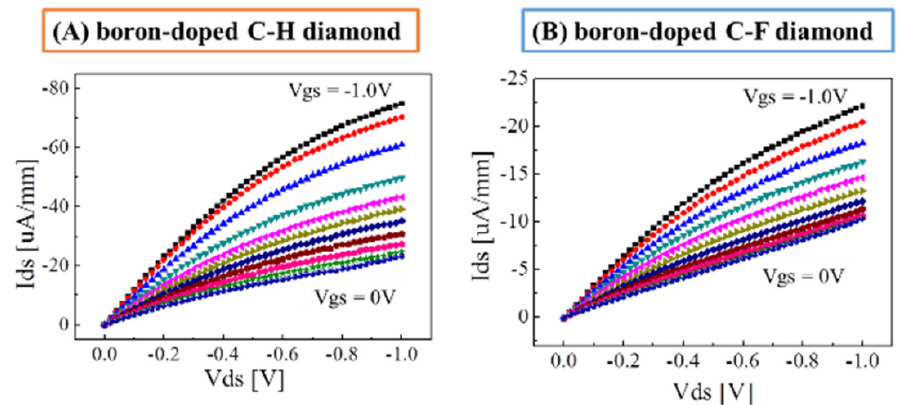
Figure 6. FET Ids–Vds characteristics at Vgs in the range of 0 V to − 1.0 V of boron-doped diamond electrolyte-solution-gate FET: ( A ) a C–H diamond SGFET and ( B ) a C–F diamond SGFET fabricated via fluorine gas treatment.